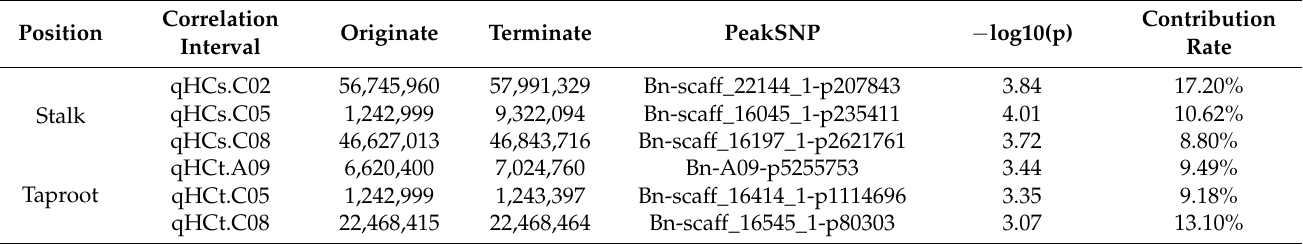
Figure 2. GWAS analysis for hemicellulose contents in stalk and taproot of Brassica napus. ( A ) Manhattan diagram of stalk hemicellulose, ( B ) QQ diagram of stalk hemicellulose, ( C ) Manhattan diagram of taproot hemicellulose and ( D ) QQ diagram of taproot hemicellulose. Table 2. Information of associated area for hemicellulose content in stalk and taproot of Brassica napus.